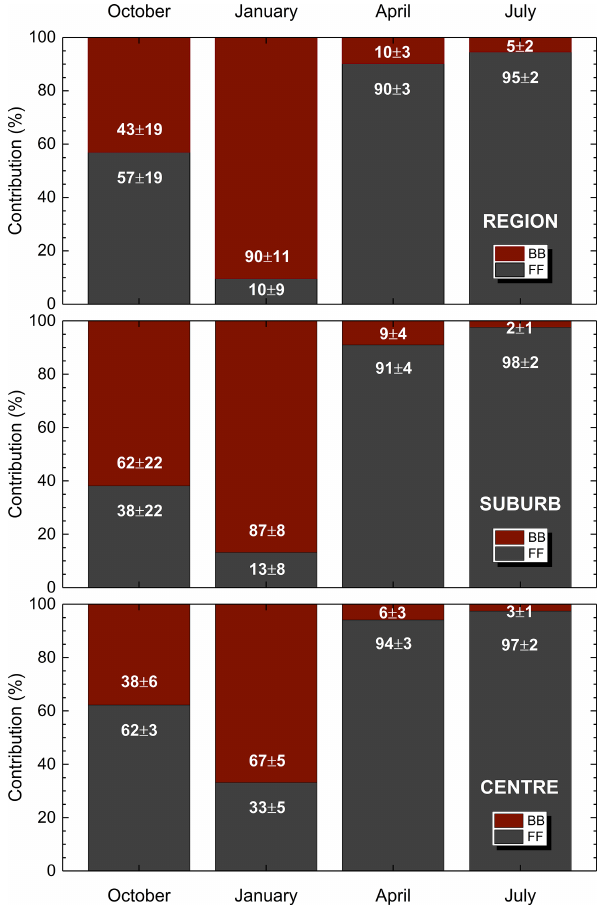
Figure 6. Distribution of mean contributions from FF combustion and BB with SDs to the PM 2 . 5 -fraction EC for regional background in the Carpathian Basin, suburban area and city centre of Budapest for different months representing different seasons. The correspond- ing median atmospheric concentrations of the EC are given in Ta- ble 2.